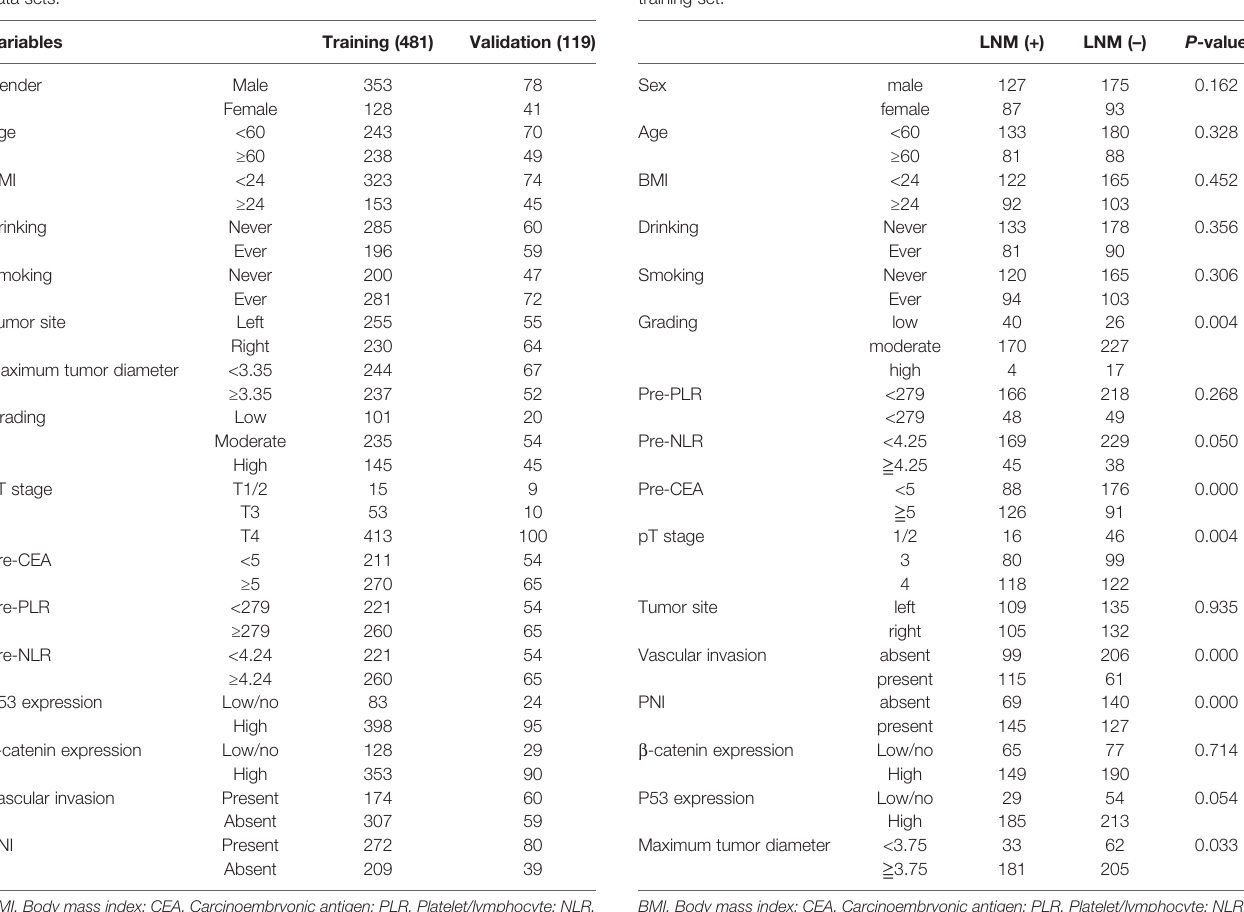
TABLE 2 | Relationship between lymph node metastasis and clinicopathology in training set.